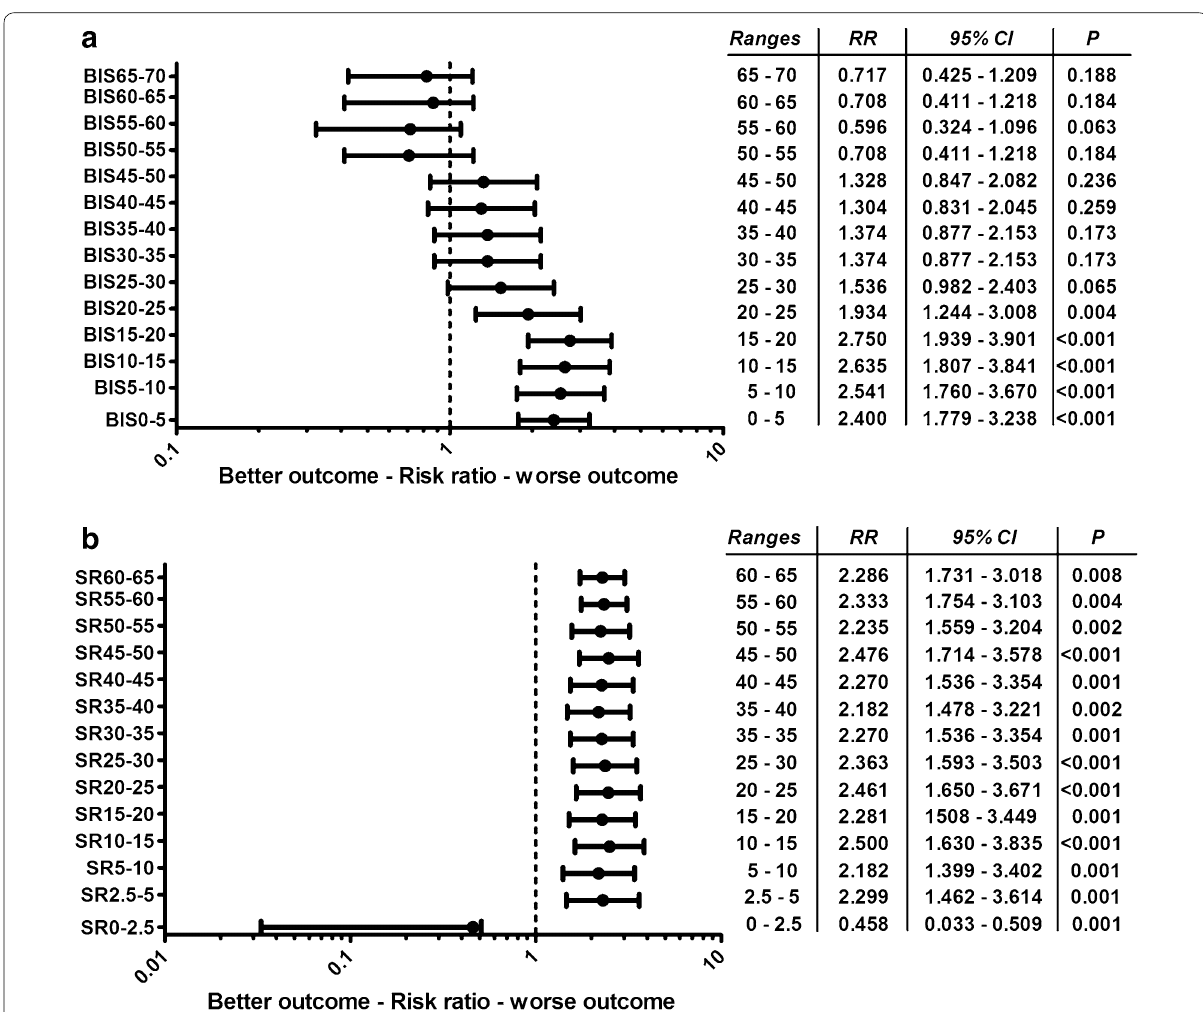
Fig. 2 Forest plots. Relative risk ratios for poor neurological outcome at 180 days post-cardiac arrest are presented for the presence between given BIS ( a ) and SR ( b ) ranges at hour 12 and 23,